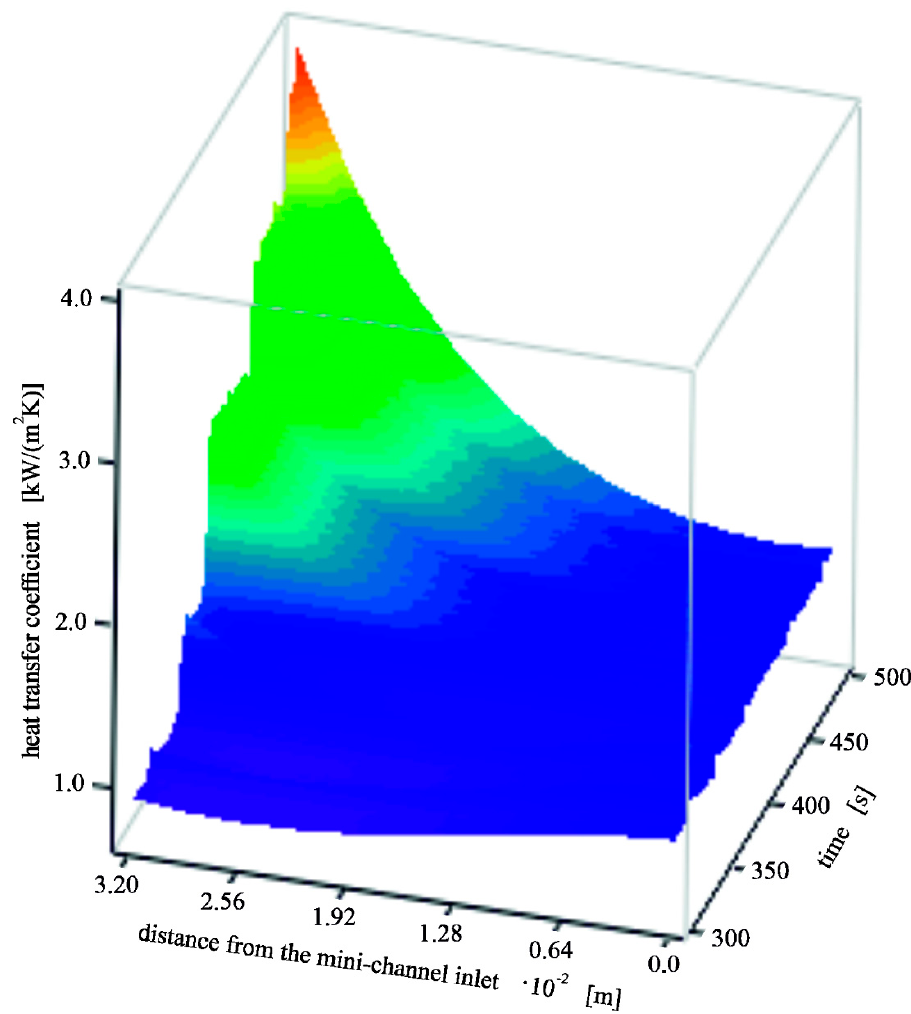
Figure 14. Heat transfer coefficient according to the CTM computation versus time and distance from the mini-channel inlet; experimental parameters are listed in Table 1.